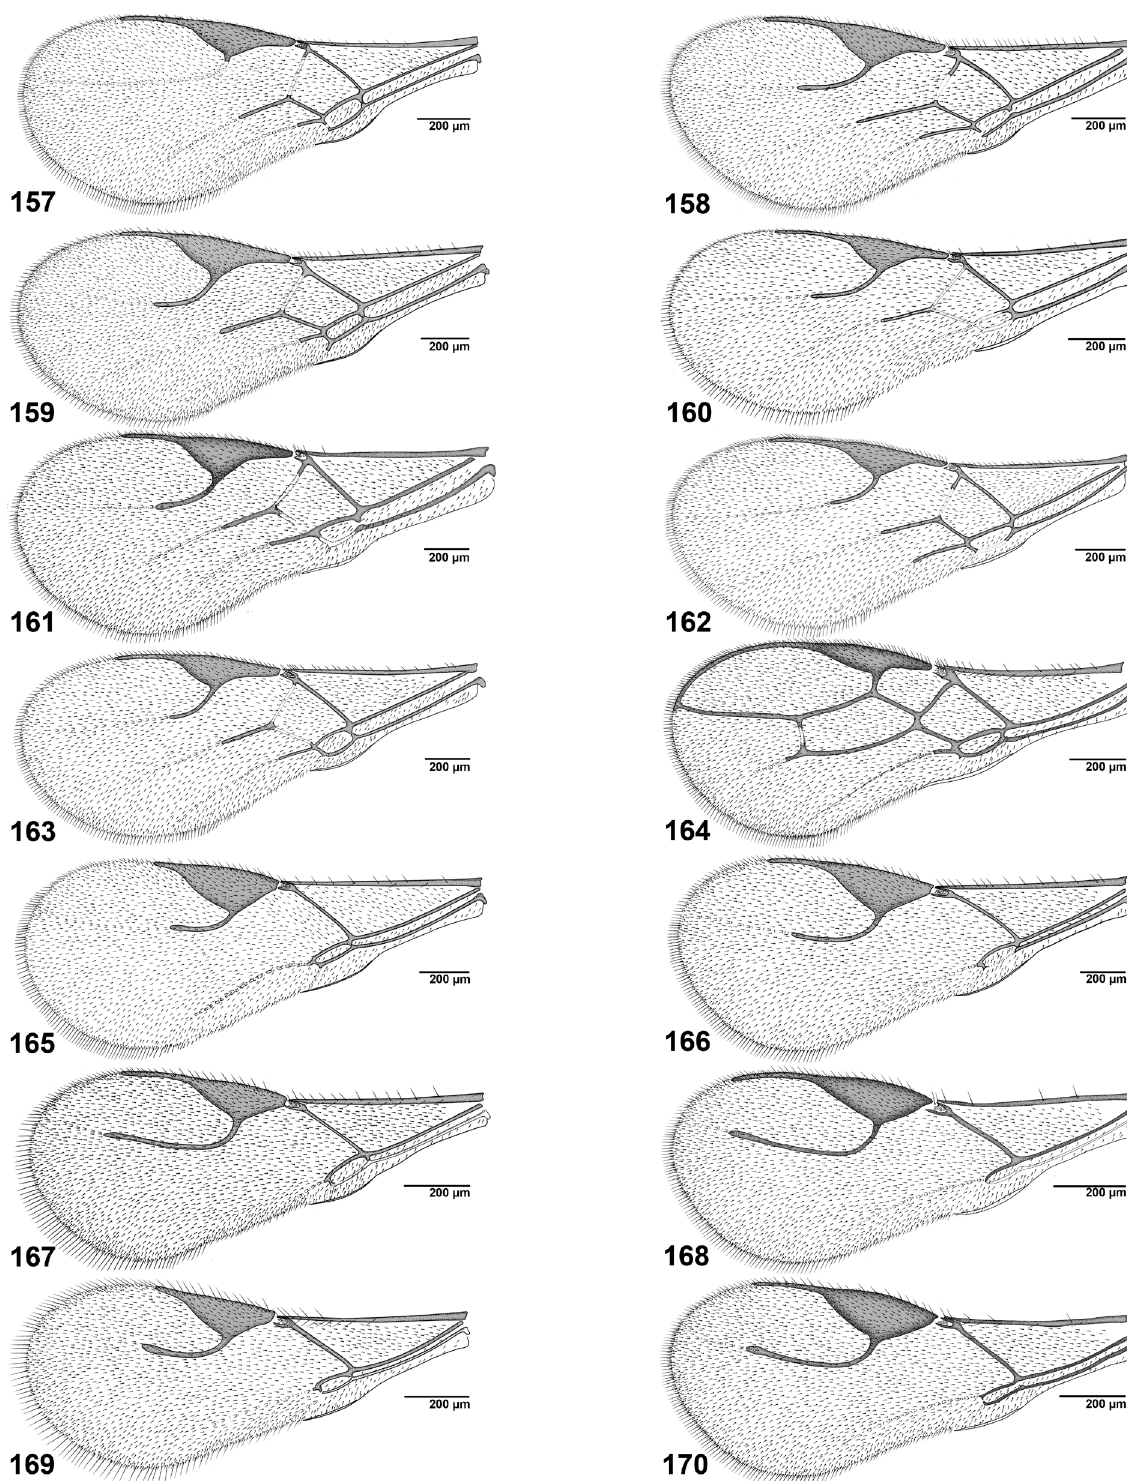
Figs 157–170. Forewing (♀): 157 . Praon orpheusi . 158 . Praon pubescens . 159 . Praon rosaecola . 160 . Praon unitum . 161 . Praon uroleucon . 162 . Praon volucre . 163 . Praon yomenae . 164 . Toxares deltiger . 165 . Trioxys asiaticus . 166 . Trioxys cirsii . 167 . Trioxys complanatus . 168 . Trioxys curvicaudus . 169 . Trioxys metacarpalis . 170 . Trioxys moshei